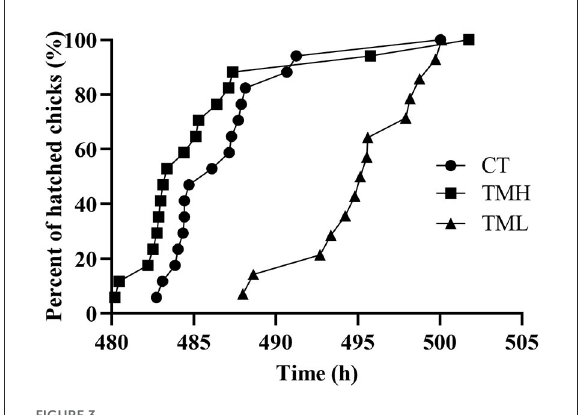
FIGURE3 Distribution of hatch after exposure to control temperature (CT, 37.6 ◦ C) and thermal manipulation with high temperature (TMH, 39 ◦ C, 8 h/day) or low temperature (TML, 20 ◦ C, 1 h/day) from embryonic day (ED) 8 to ED 15. The Y axis is percent of hatched birds and the X axis is the incubation duration.